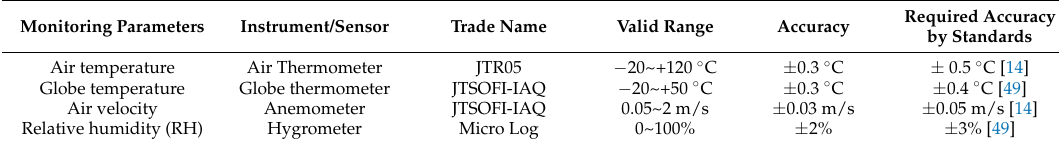
Table 3. Monitoring parameters and specification of equipment.